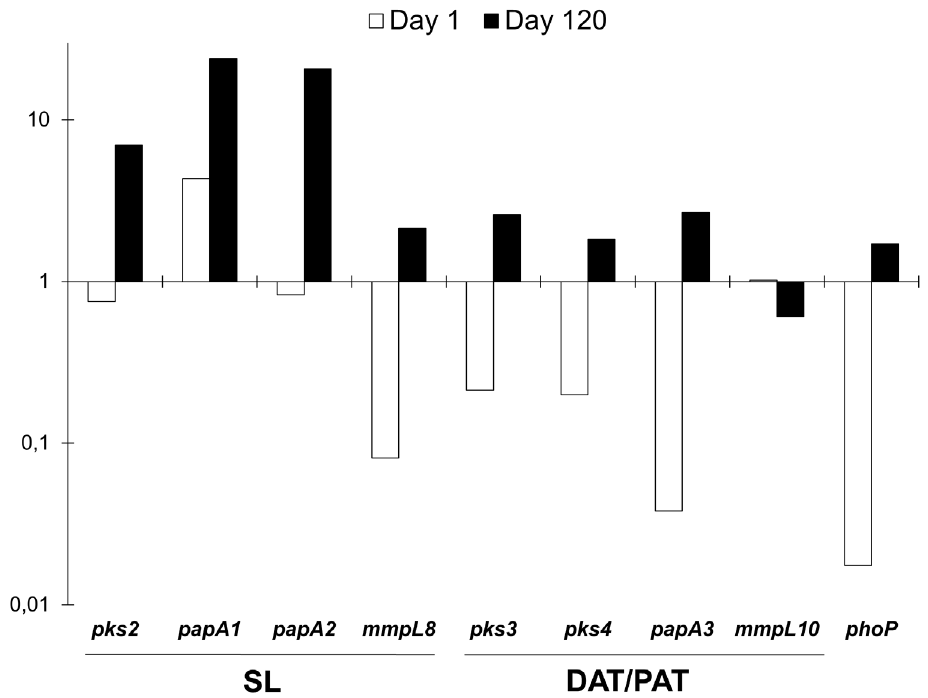
Figure 5. Invivo transcription of genes of M.tuberculosis H37Rv during progressive tuberculosis in mice. The relative quantification is expressed as the ratio of infection at days 1 and 120/transcription at day 28 of progressive infection TB. The presented data have statistically significant differences compared to transcription values at day 28 of progressive infection TB ( P , 0.05).